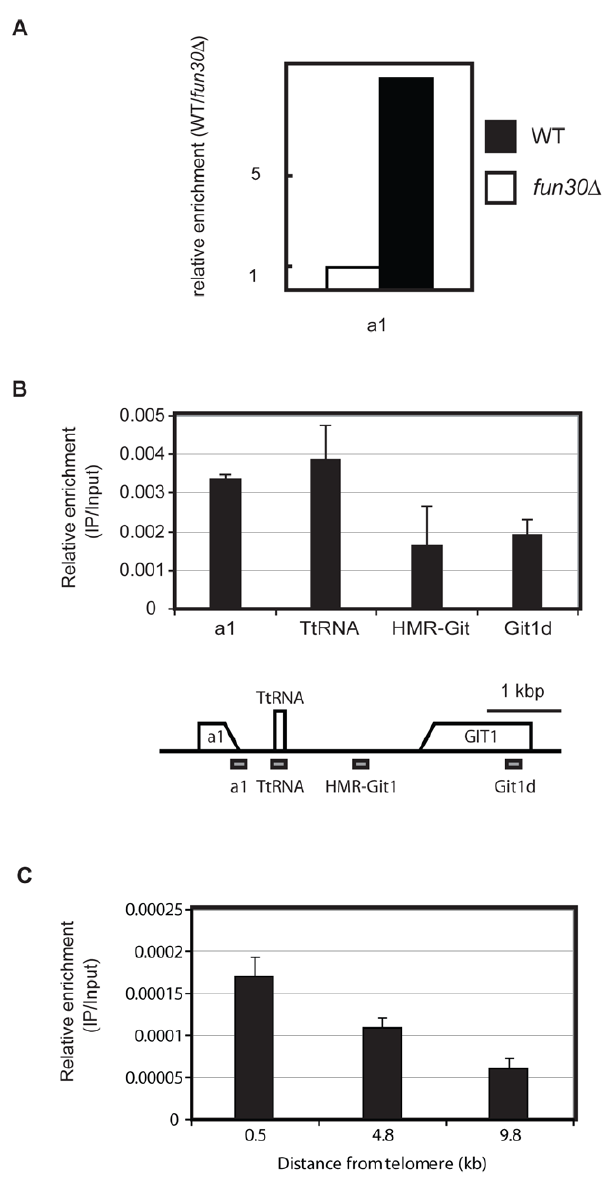
Figure 6. Fun30 binds at the silent HMR locus. A. Validation of the specificity of the affinity purified Fun30 antibody for chromatin immunoprecipitation (ChIP). Control (wt) and fun30 D cells were analyzed by ChIP with Fun30 antibody. Immunoprecipitated DNA was quantified at the a1 locus using quantitative PCR, corrected for background signal using the IgG control, and normalized relative to input. Shown is a representative result of two repeat experiments. B. upper panel: ChIP analysis of Fun30 occupancy across the HMR barrier. Error bars are standard deviation of the two biological replicates of this experiment. Lower panel: Diagram of the HMR barrier region. Arrows indicate the orientation of specific genes in the region. Small bars underneath indicate the relative position of qPCR probes used in ChIP analyses. C. Fun30 occupancy near the telomere VIR.